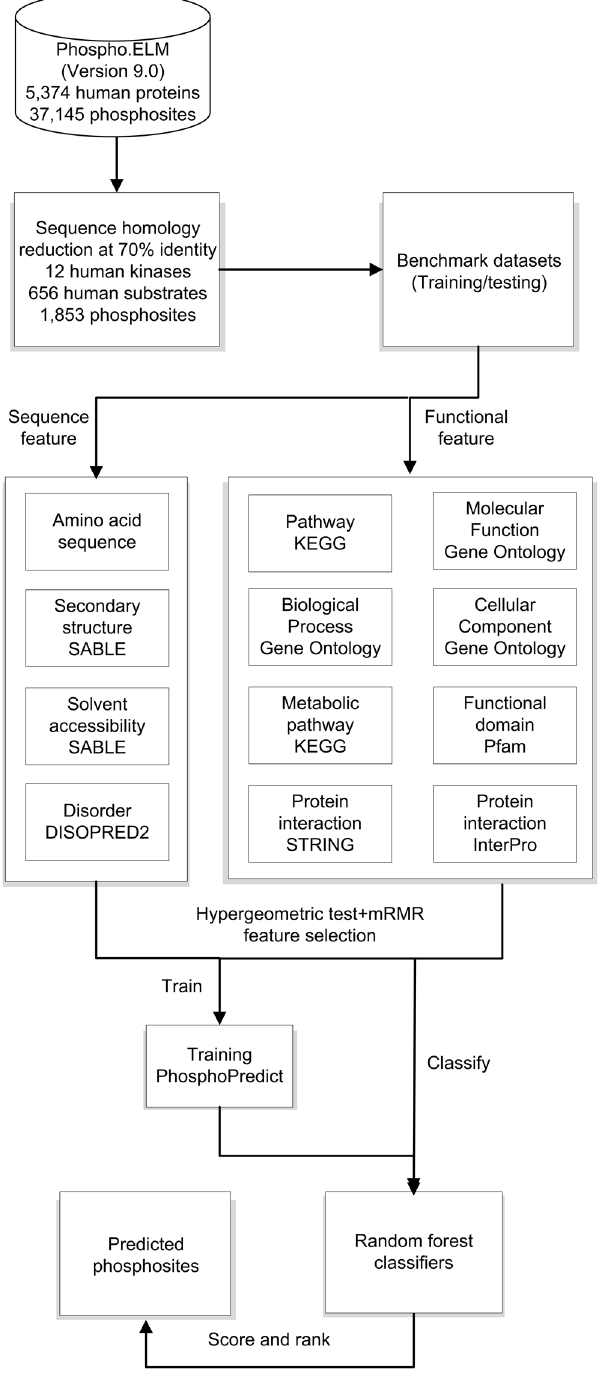
Figure 1. Workflow of the PhosphoPredict approach. Benchmark training/testing datasets were extracted from the Phospho.ELM database after removing sequence redundancy (70% sequence identity) using the CD- HIT program 39 . After feature selection using mRMR and statistical analysis of over-represented and under- represented feature terms using hypergeometric tests, significant sequence, structural, and functional features were extracted and used as inputs to train RF classifiers. Classifier performance was assessed using randomized 5-fold cross-validation and independent